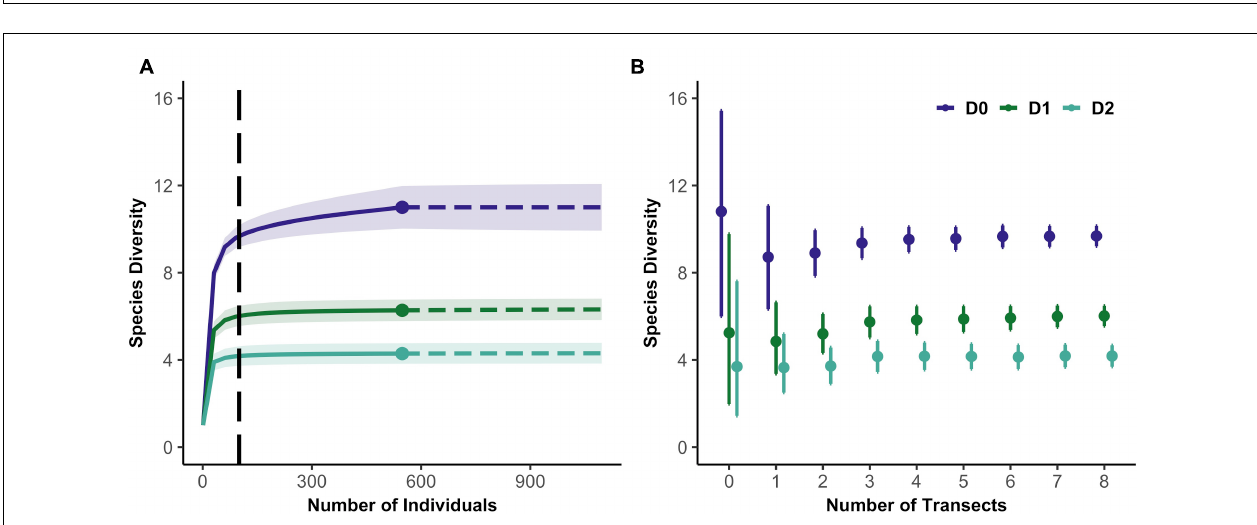
FIGURE 2 | (A) Example of an individual-based rarefaction curve for the first three Hill numbers from a PISCO sample. Vertical dashed line indicates the extrapolation value to 100 individuals. (B) Example of 200 random resamples of data from the same sampling event. 95% confidence intervals shown.